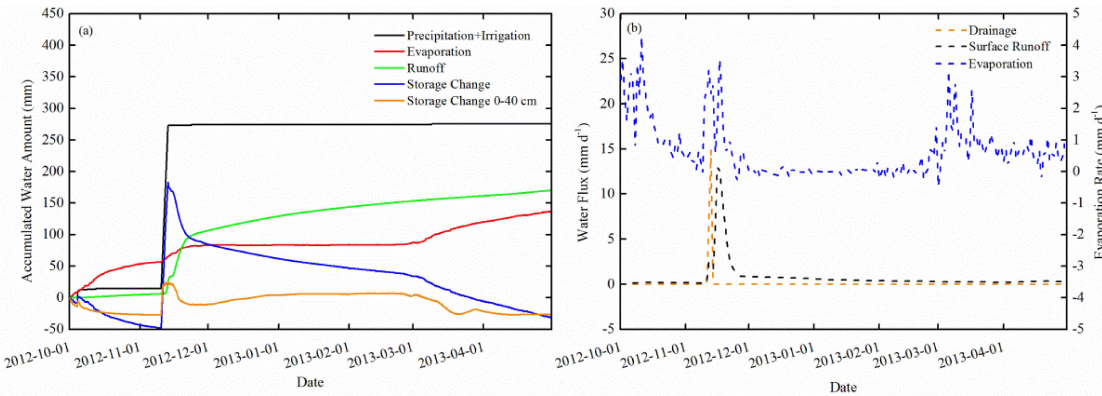
Figure 5. Water balance for the soil profile during the 2012/2013 winter. ( a ) Accumulated water amount: the black, red, green, blue, and orange lines denote precipitation/irrigation, evaporation, runoff, whole soil profile water storage change, and 0–40 cm soil layer water storage change, respectively; ( b ) water flux: the black, orange, and blue dashed lines are for drainage, surface runoff, and evaporation rate,